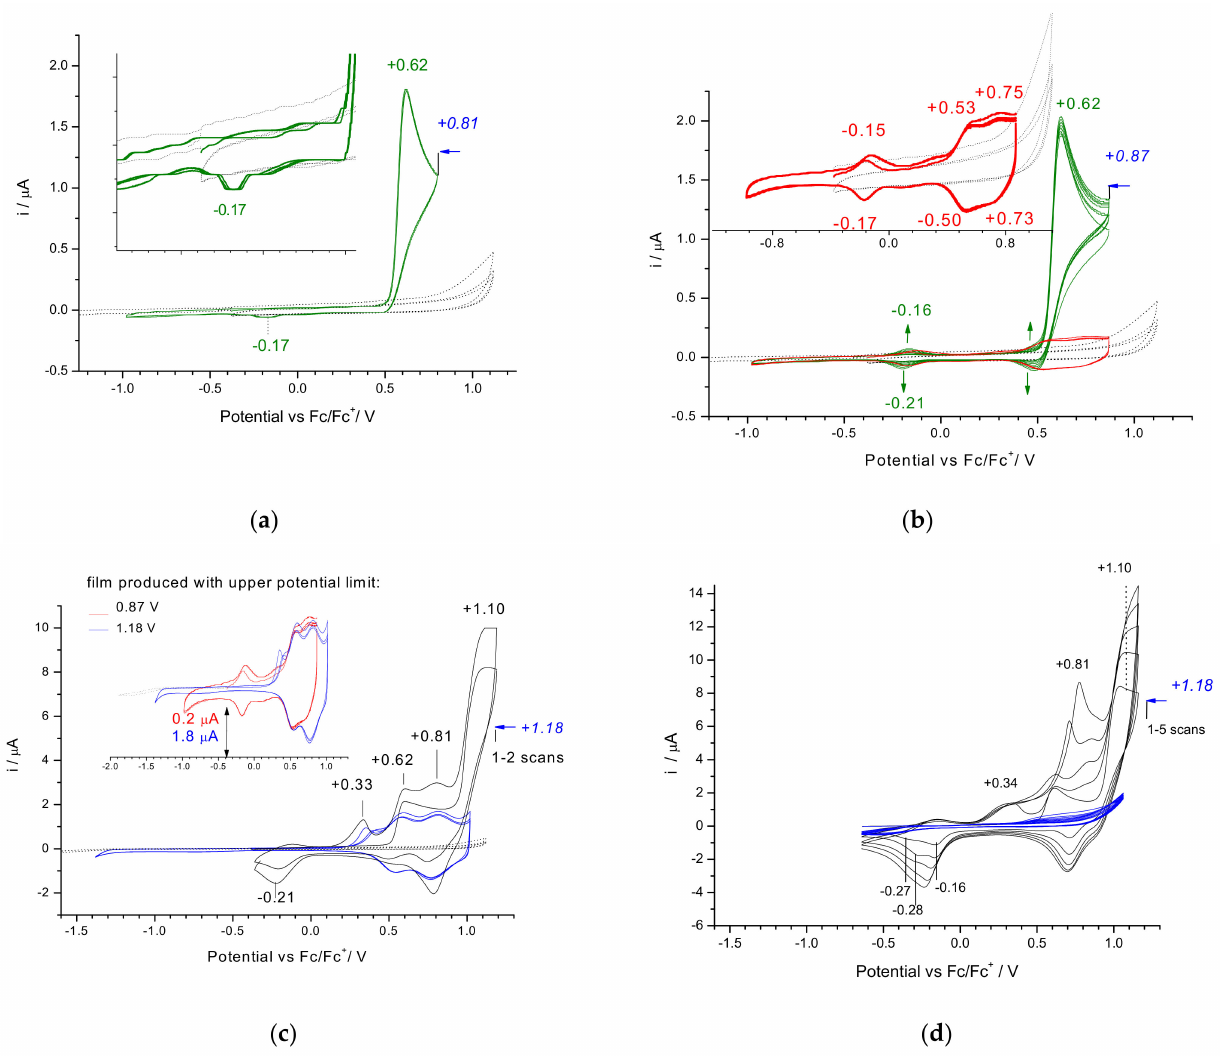
Figure 3. CVs limited to +0.81 V ( a ), +0.87 V ( b ) and +1.18 V ( c , d ) in 1 mM of 1 and 0.1 M Bu 4 NBF 4 in DCM; potential sweep of p(1)-I ( red CVs ) ( b , c ), p(1)-II ( blue CVs ) ( c ) and p(1)-III ( blue CVs ) ( d ) in monomer-free in 0.1 M Bu 4 NBF 4 /DCM solution; 50